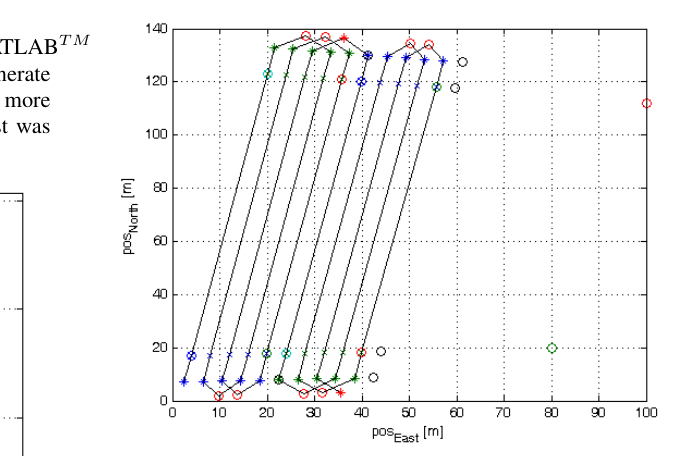
Figure 5: Advanced mission planning with additional segmenta- tion of the flight area in order to avoid unnecessary flight time at the end of the area of